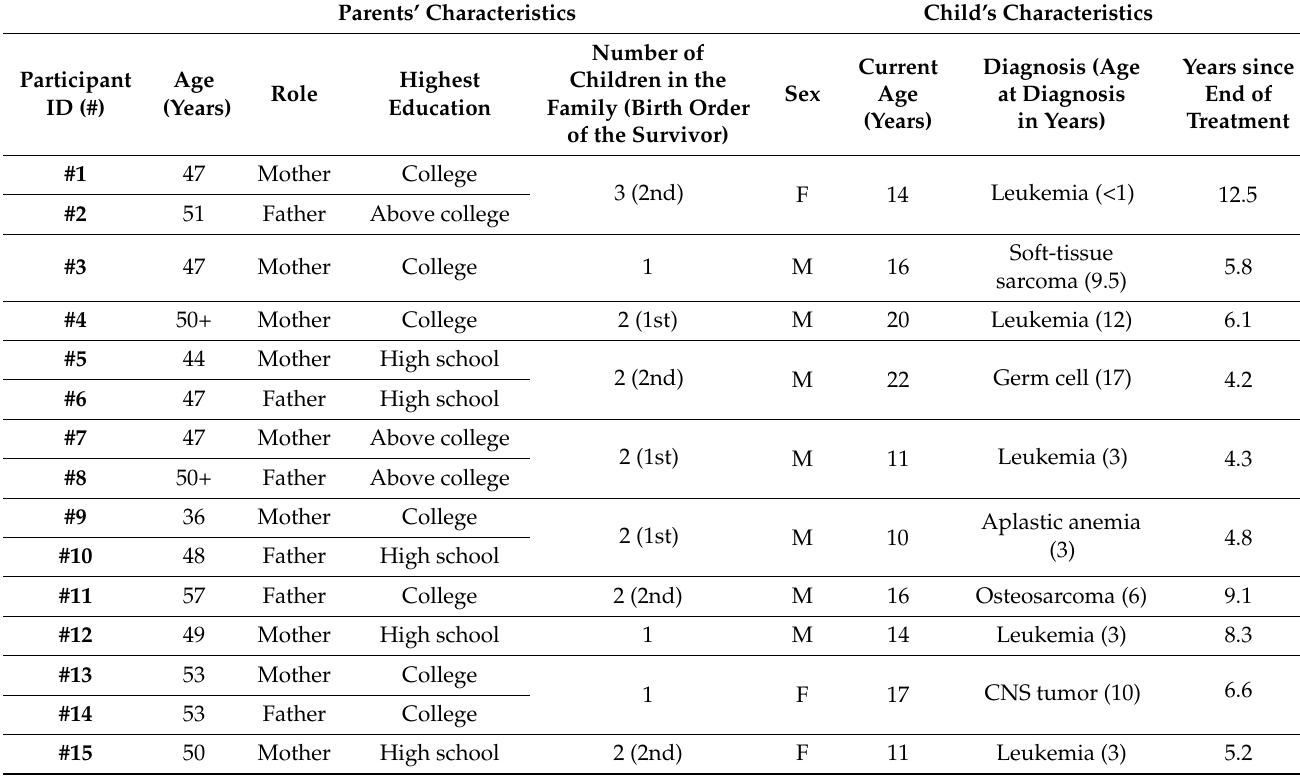
Table 1. Demographic characteristics of